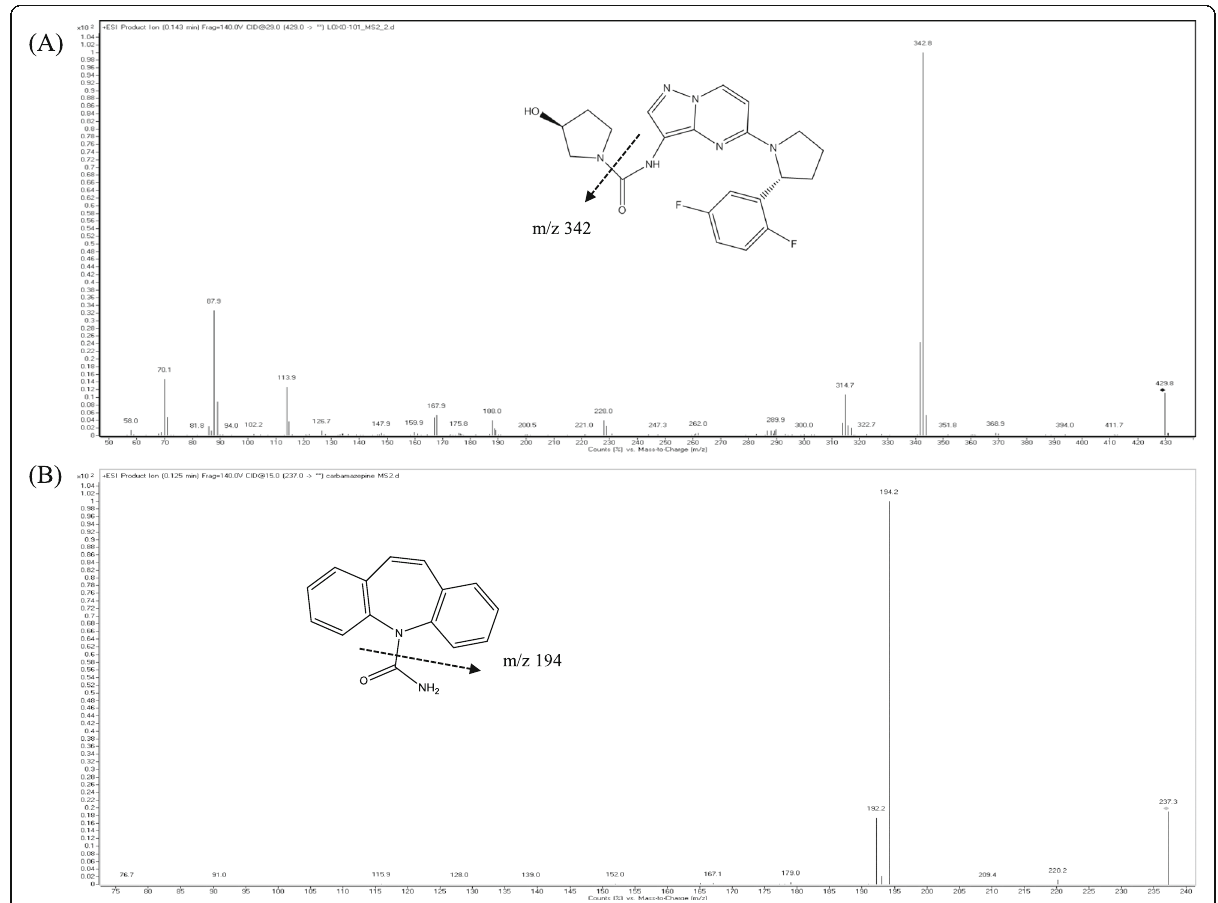
Fig. 1 The structures and product-ion scan spectra of a larotrectinib and b carbamazepine